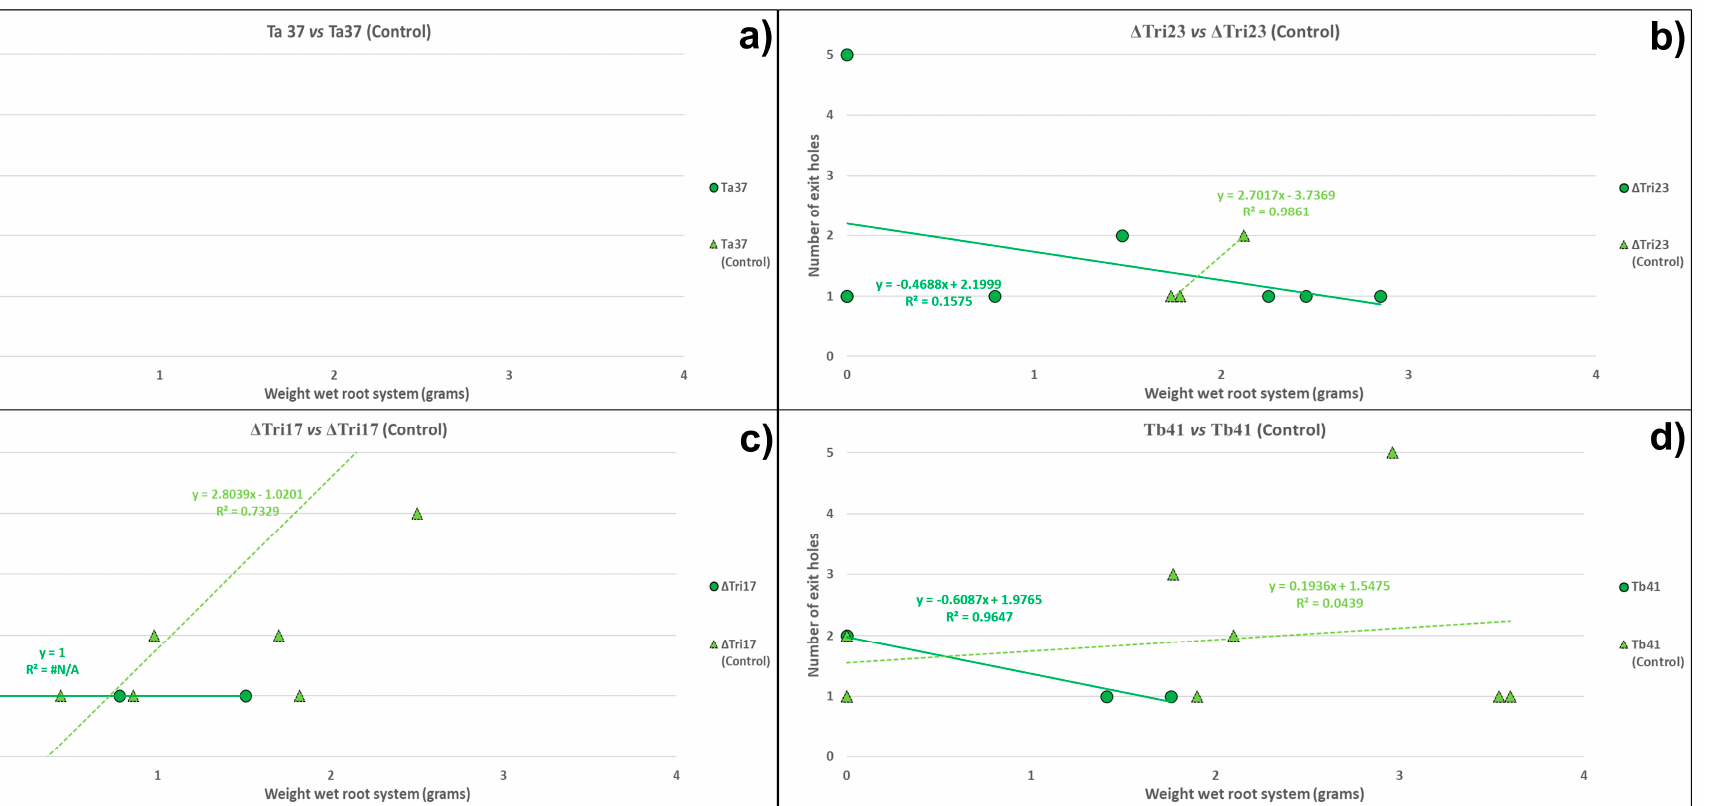
Figure 5. Linear regression of wet weight root system (WWRS) of P. vulgaris plants ( x -axis) versus number of exit holes (NEH) of P. vulgaris beans ( y -axis). “Round Intense Green Point” means bean samples sprayed with Trichoderma strains: Ta37, ( b ) ∆ tri23 , ( c ) ∆ tri17 and d) Tb41. “Triangular Light Green Point” means the controls beans samples sprayed with distilled water: ( a ) Ta37 (control), ( b ) ∆ tri23 (control), ( c ) ∆ tri17 (control) and ( d ) Tb41 (control). Linear regression trendlines are coloured based on the treatment (“Continuous Intense Green Line” represents bean samples sprayed with Trichoderma strains; “Discontinuous Triangular Light Green Line” indicates bean samples sprayed with distilled